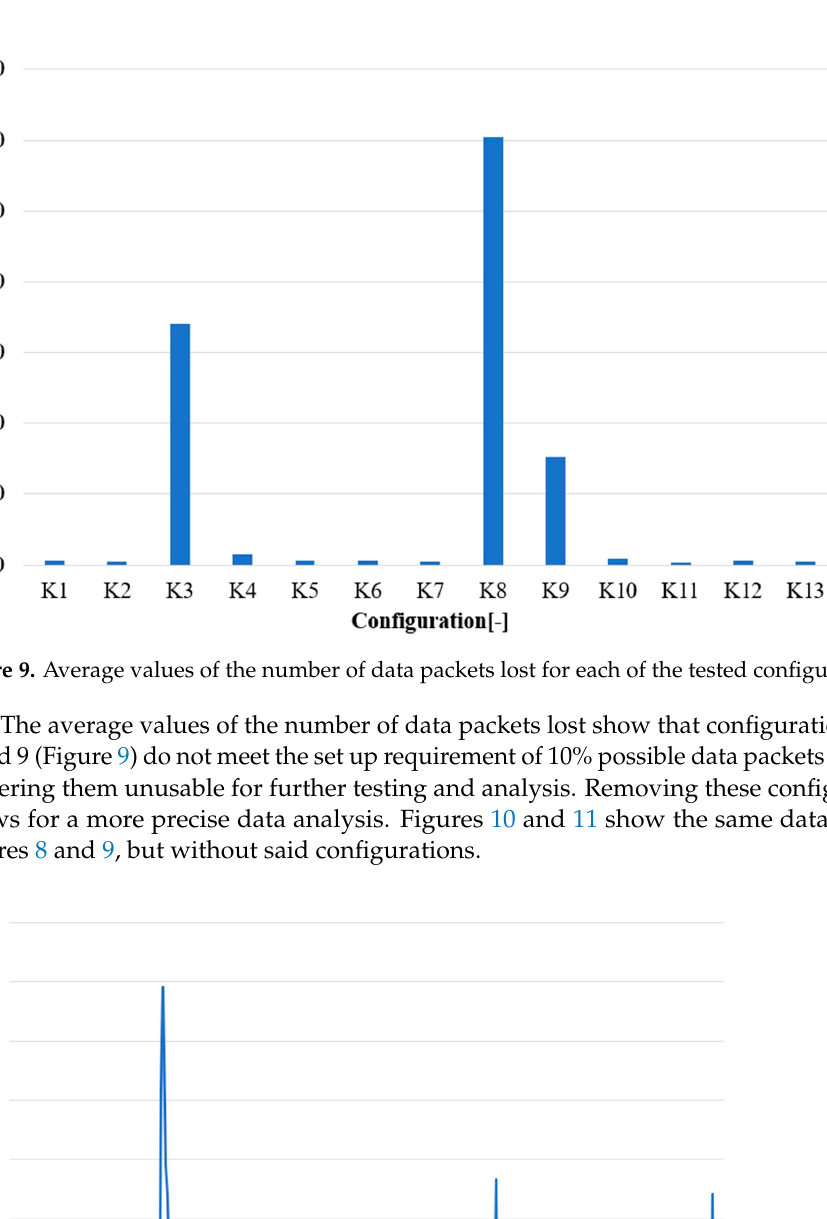
Figure 8. The number of data packets lost in each of the tests carried out.